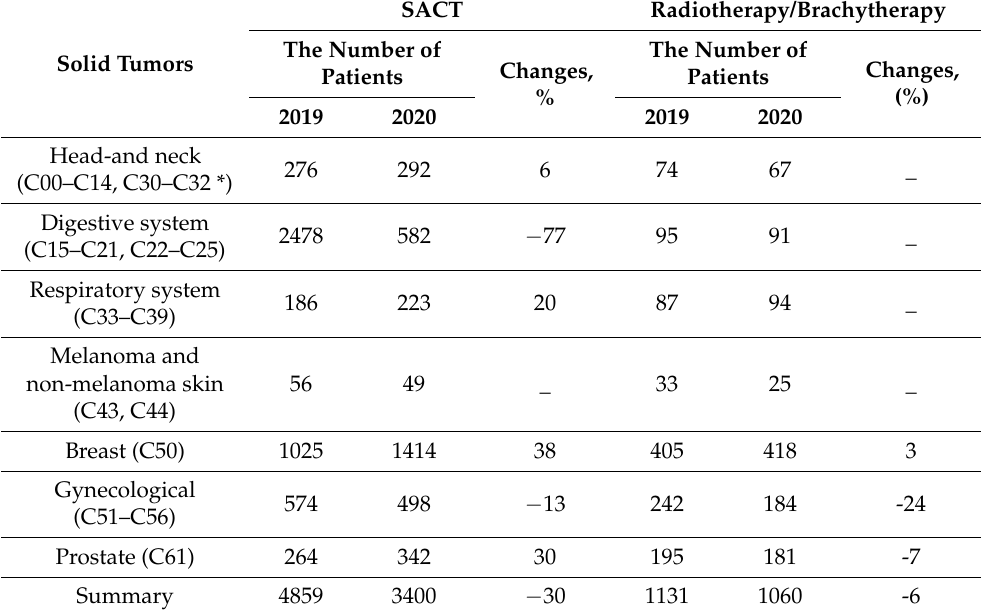
Table 2. Descriptive statistics of patients receiving SACT or radiotherapy by tumor localization.